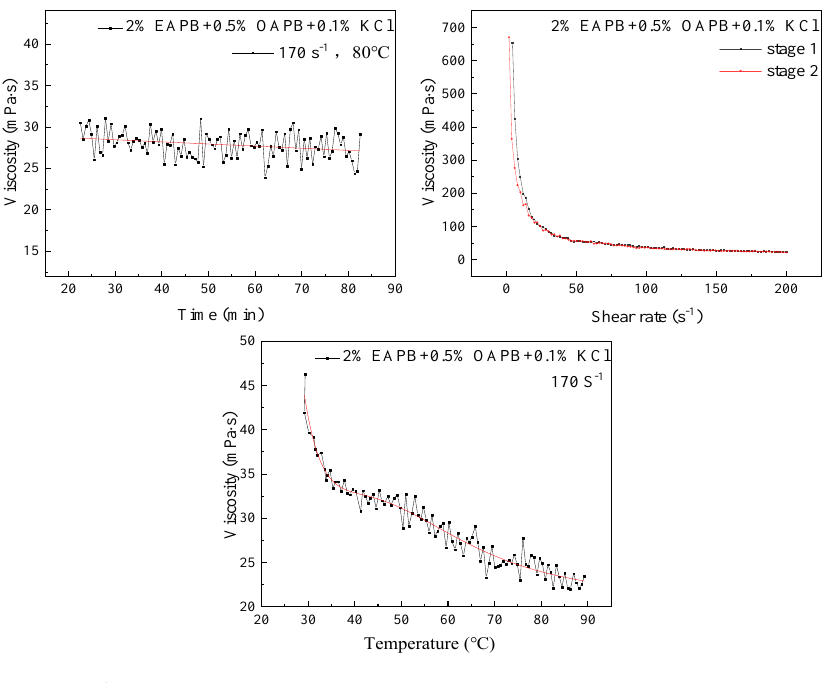
Figure 9. Shear resistance test.